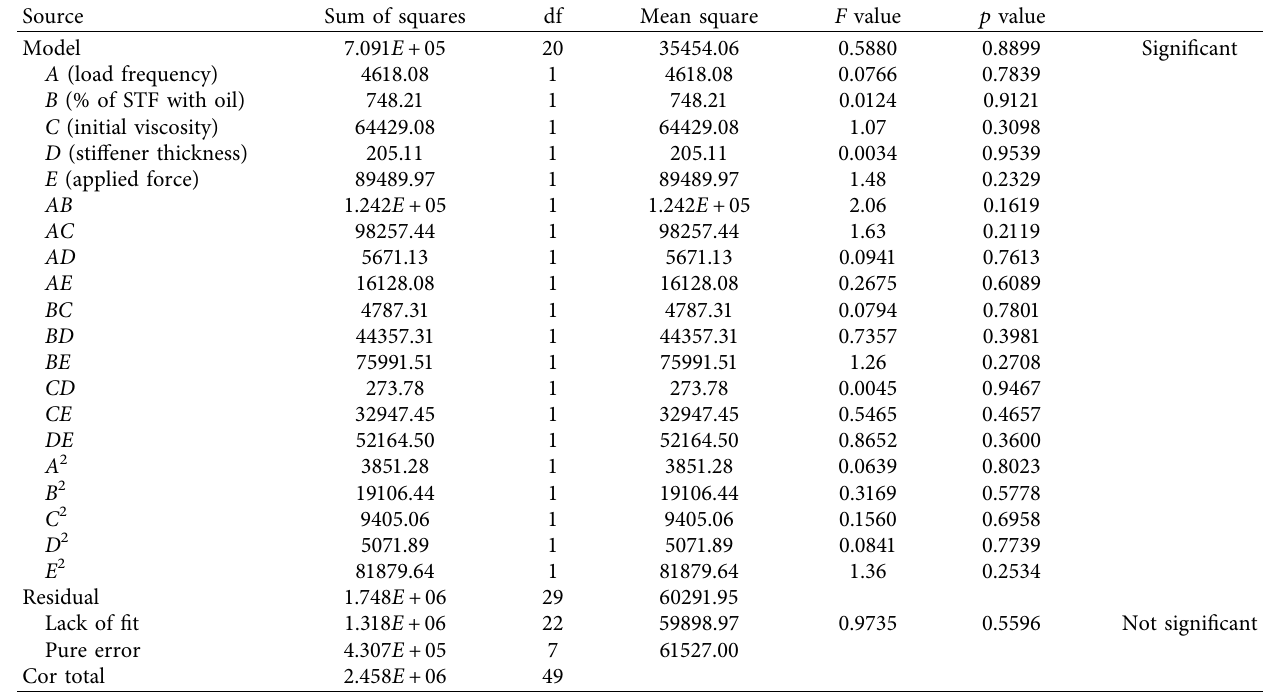
Table 4: ANOVA for damping